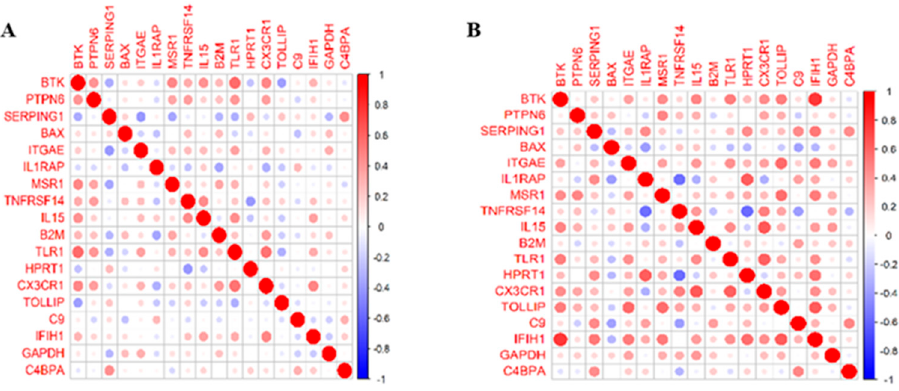
Figure 4. ( A ) A correlation gene matrixof control samples within the training dataset. ( B ) A correlation matrix of steatosis samples within the training dataset.